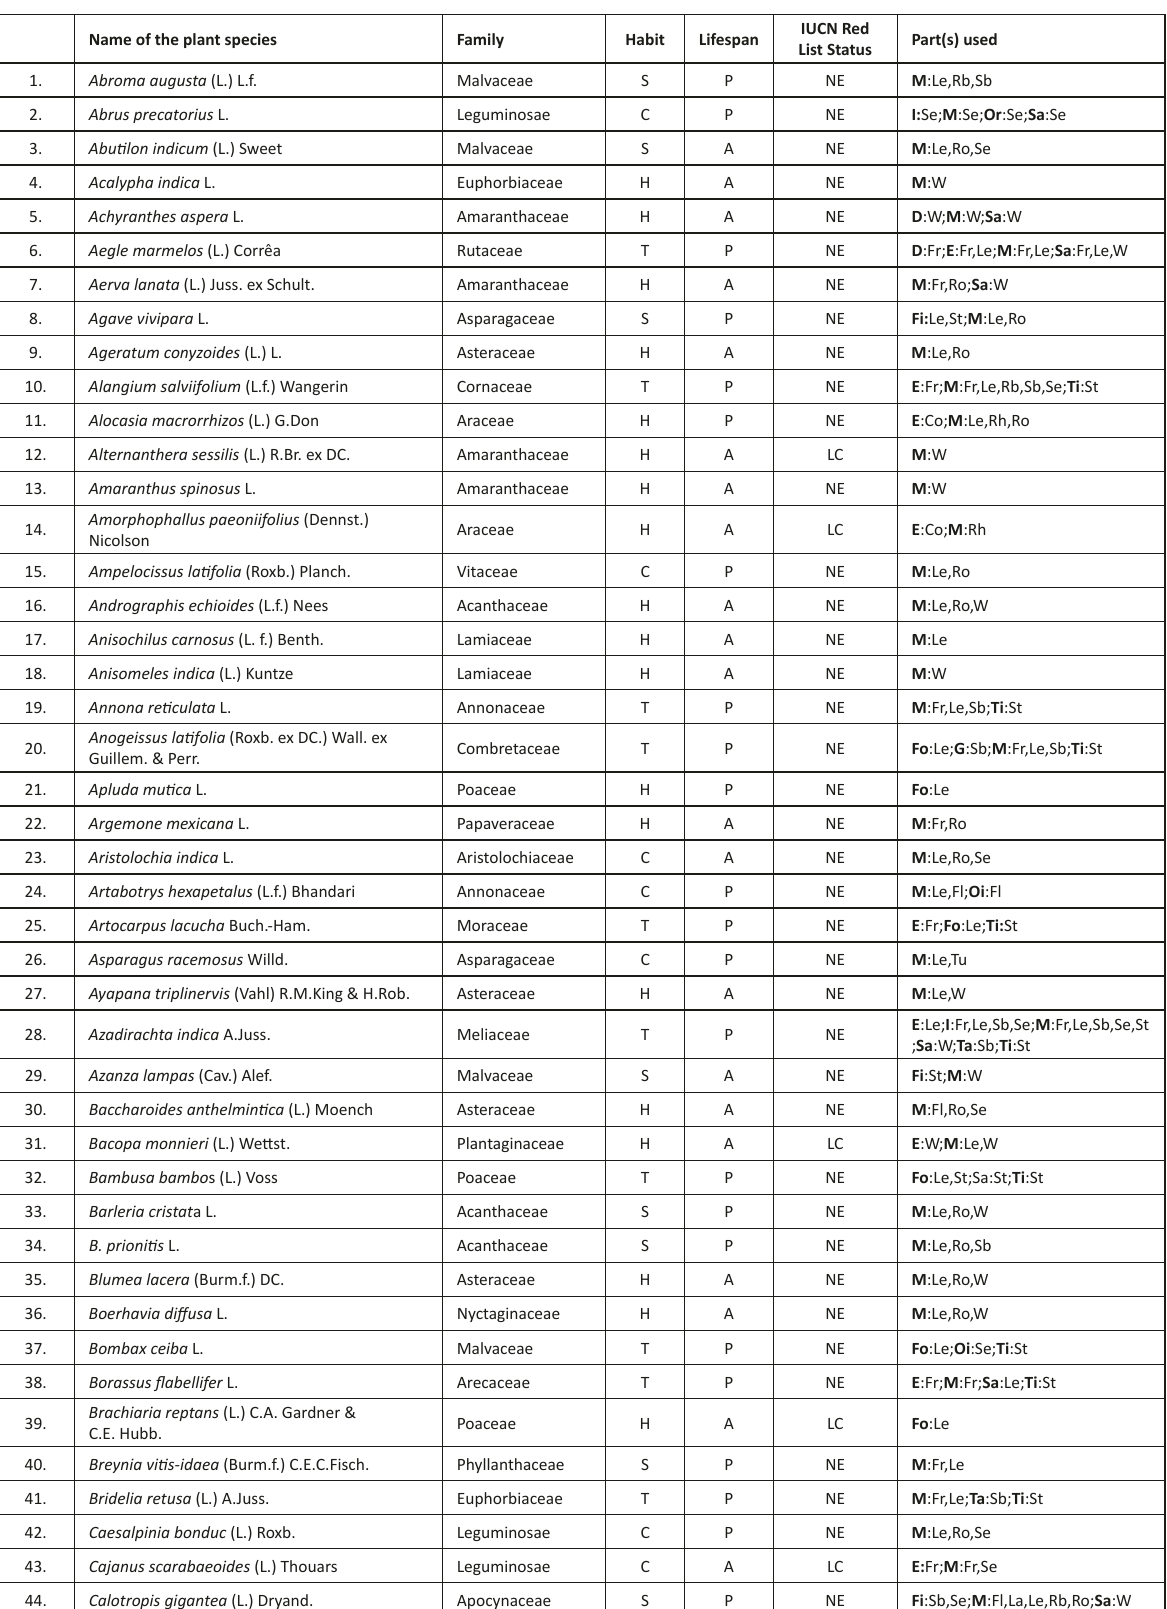
Table 1. Angiosperms in Joypur Joysini Matar Than sacred grove. Name of the plant